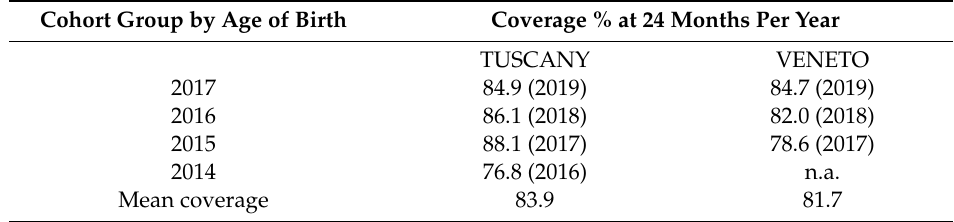
Table 1. 4CMenB coverage in Tuscany and Veneto during the post-vaccination era (cohort at 24th months). Cohort Group by Age of Birth Coverage % at 24 Months Per Year